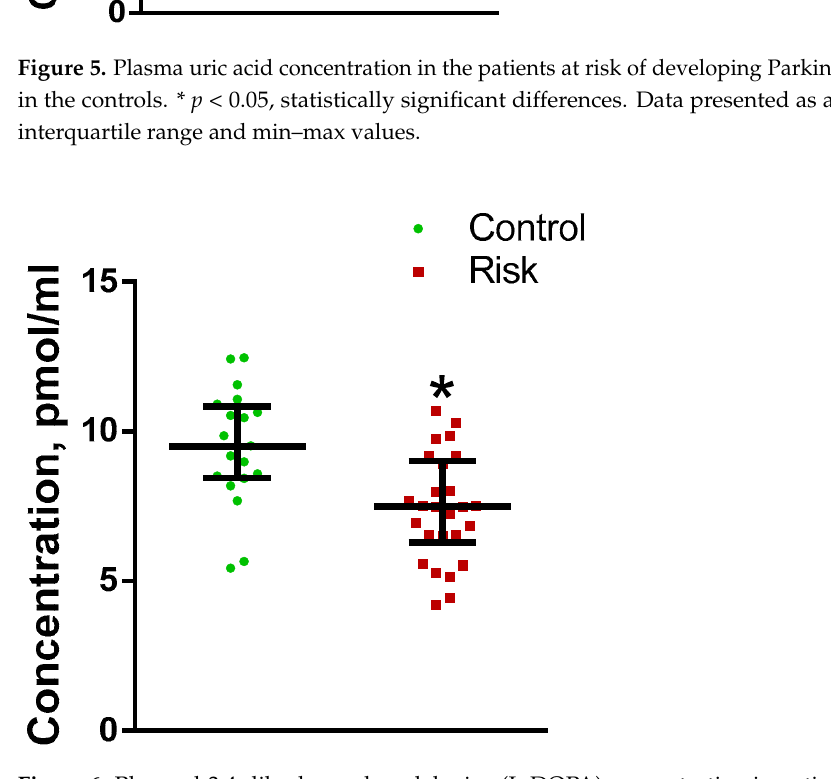
Figure 7. L-3,4-dihydroxyphenylalanine (L-DOPA) concentration in the risk subgroup with mild non-Parkinsonian motor impairment (UPDRS > 2.5 points) and in the risk subgroup without mo- tor impairment (UPDRS ≤ 2 points) compared with control. * p < 0.05, statistically significant dif- ferences. UPDRS—Unified Parkinson’s Disease Rating Scale. Data presented as a median with an interquartile range and min–max values. 2.3. Quantification of Total, Monomeric, and Oligomeric Plasma α -Synuclein in Patients at Risk for Developing Parkinson’s Disease We found no differences in the plasma concentrations of total α -synuclein, mono- meric α -synuclein, and oligomeric α -synuclein in patients at risk of developing PD and in controls (Figure 8).